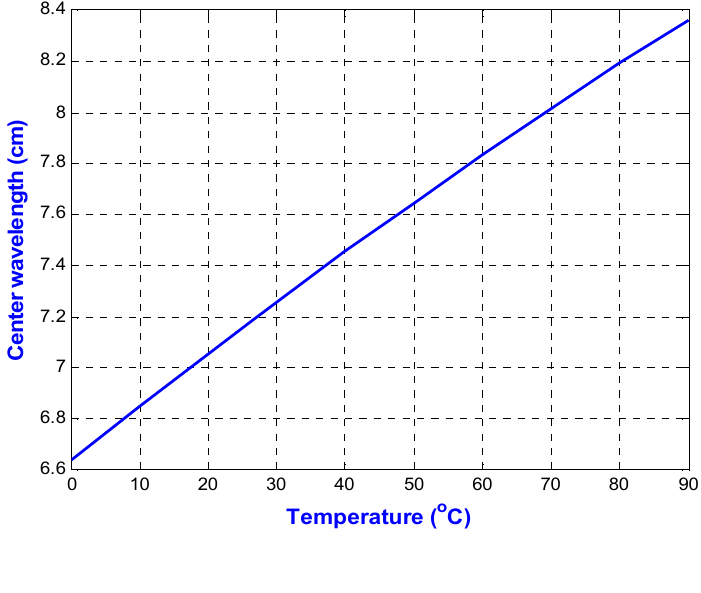
Figure 10. The relationship between the center carrier wavelength and